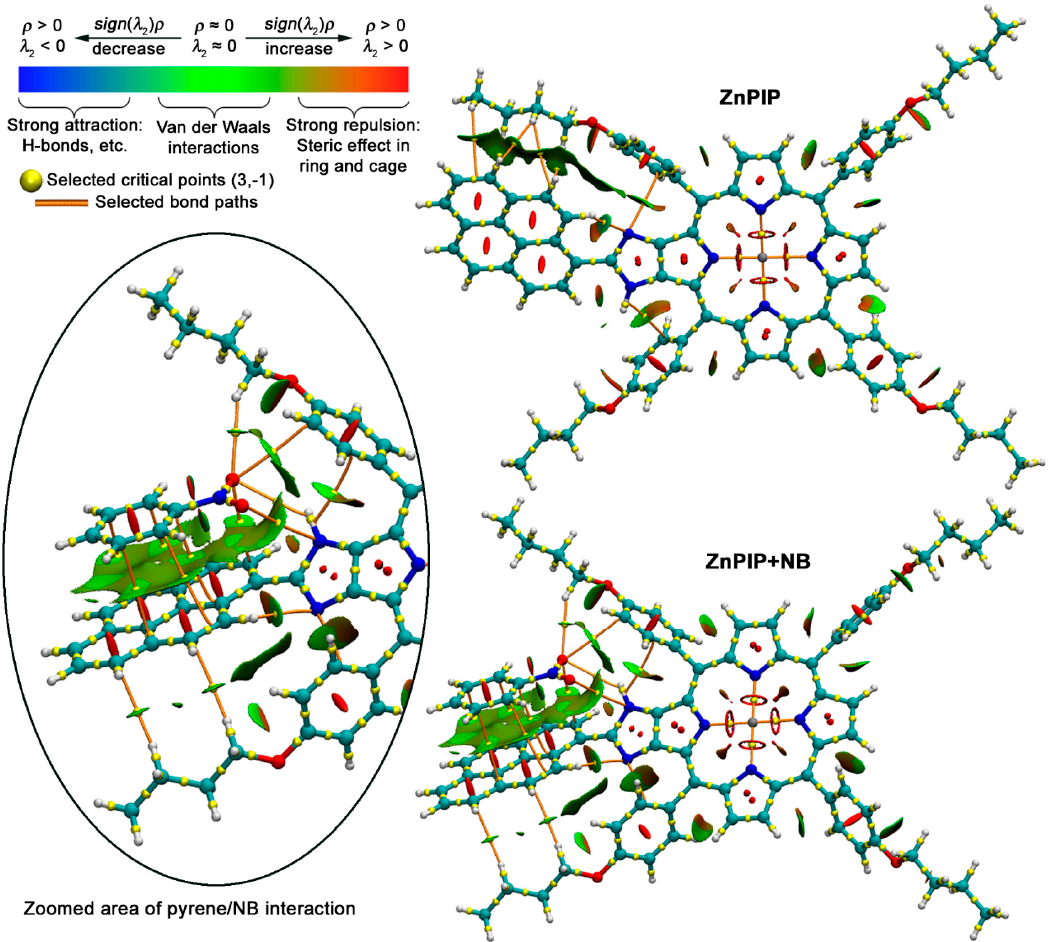
Figure 10. NCI plots for ZnPIP and ZnPIP+NB molecules with critical points (3,-1) and bond paths indicating noncovalent interactions. The inset in top left corner shows the qualitative dependence of the isosurface colour on the strength of the noncovalent interaction, with some examples of corresponding interactions listed. Geometries were optimized at r 2 SCAN-3c level of theory using CPCM solvation model for toluene media.